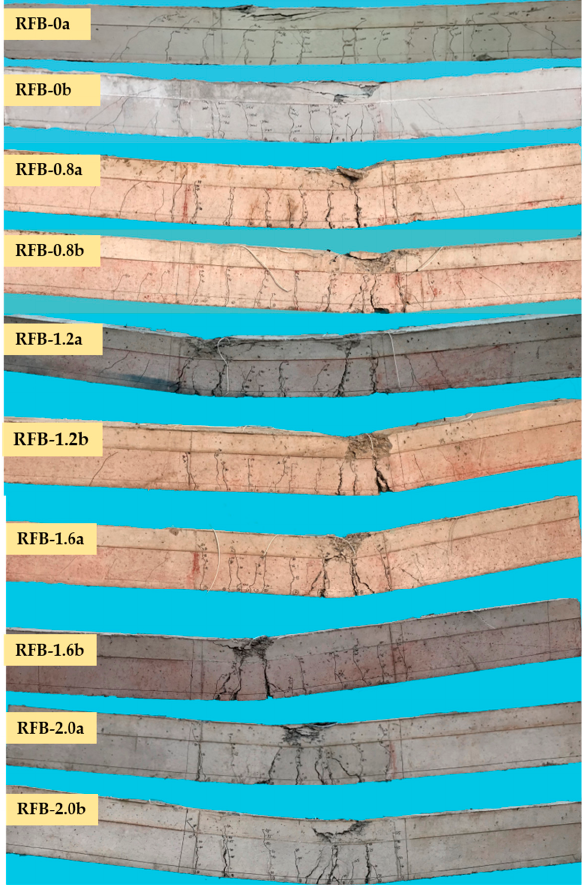
Figure 7. Crack distribution and failure patterns of the test beams.